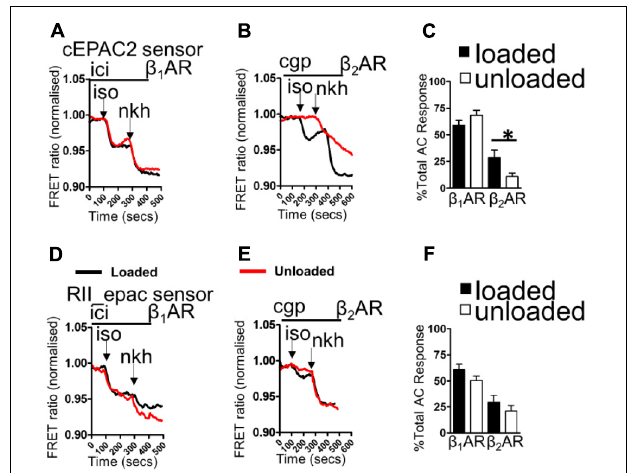
FIGURE 1 | (A) Illustrative traces showing β 1 AR-cAMP (ICI+ISO) and full AC-cAMP (NKH) responses measured by FRET microscopy using the cEPAC2 sensor in loaded and unloaded cells. (B) Illustrative traces showing β 2 AR-cAMP (CGP+ISO) and full AC-cAMP (NKH) responses measured by FRET microscopy using the cEPAC2 sensor in loaded and unloaded cells. (C) Graph presenting mean β 1 AR-cAMP and β 2 AR-cAMP responses as a function of total AC responses for loaded and unloaded cells. cEPAC2 sensor, β 1 AR-cAMP (loaded 58.78 ± 4.82% vs. unloaded 68.12 ± 4.85% N,n 5/10-13 mean ± SEM, NS). cEPAC2, β 2 AR-cAMP (loaded 28.51 ± 7.18% vs.